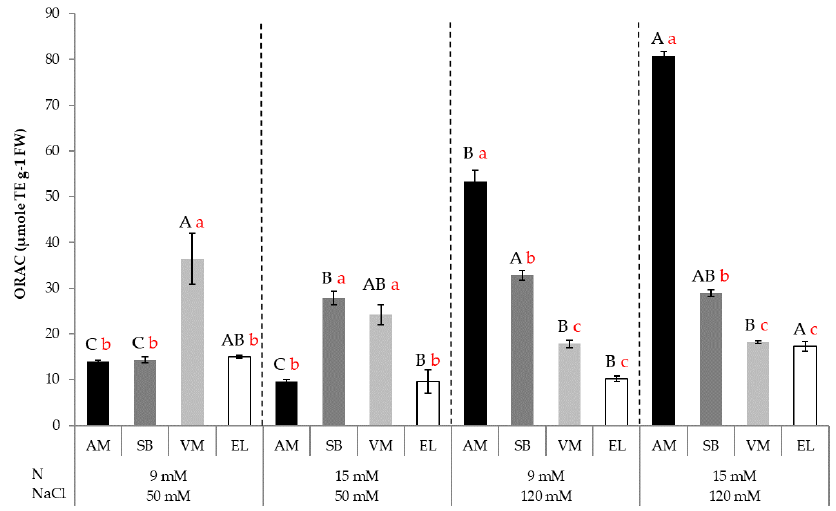
Figure 7. ORAC (moles TE g − 1 ) in Arthrocnemum macrostachyum (AM), Salicornia brachiata (SB), and Sarcocornia fruticosa ecotypes (EL and VM). LN under different combinations of N (9 and 15 mM) and NaCl (50 and 120 mM). Means plus standard errors ( ± SE) are shown. Different uppercase letters show significant differences between treatments of one ecotype (same color bars), and different lowercase red letters show significant differences between ecotypes within the same treatment (Tukey’s HSD, p ≤ 0.05, n = 3).